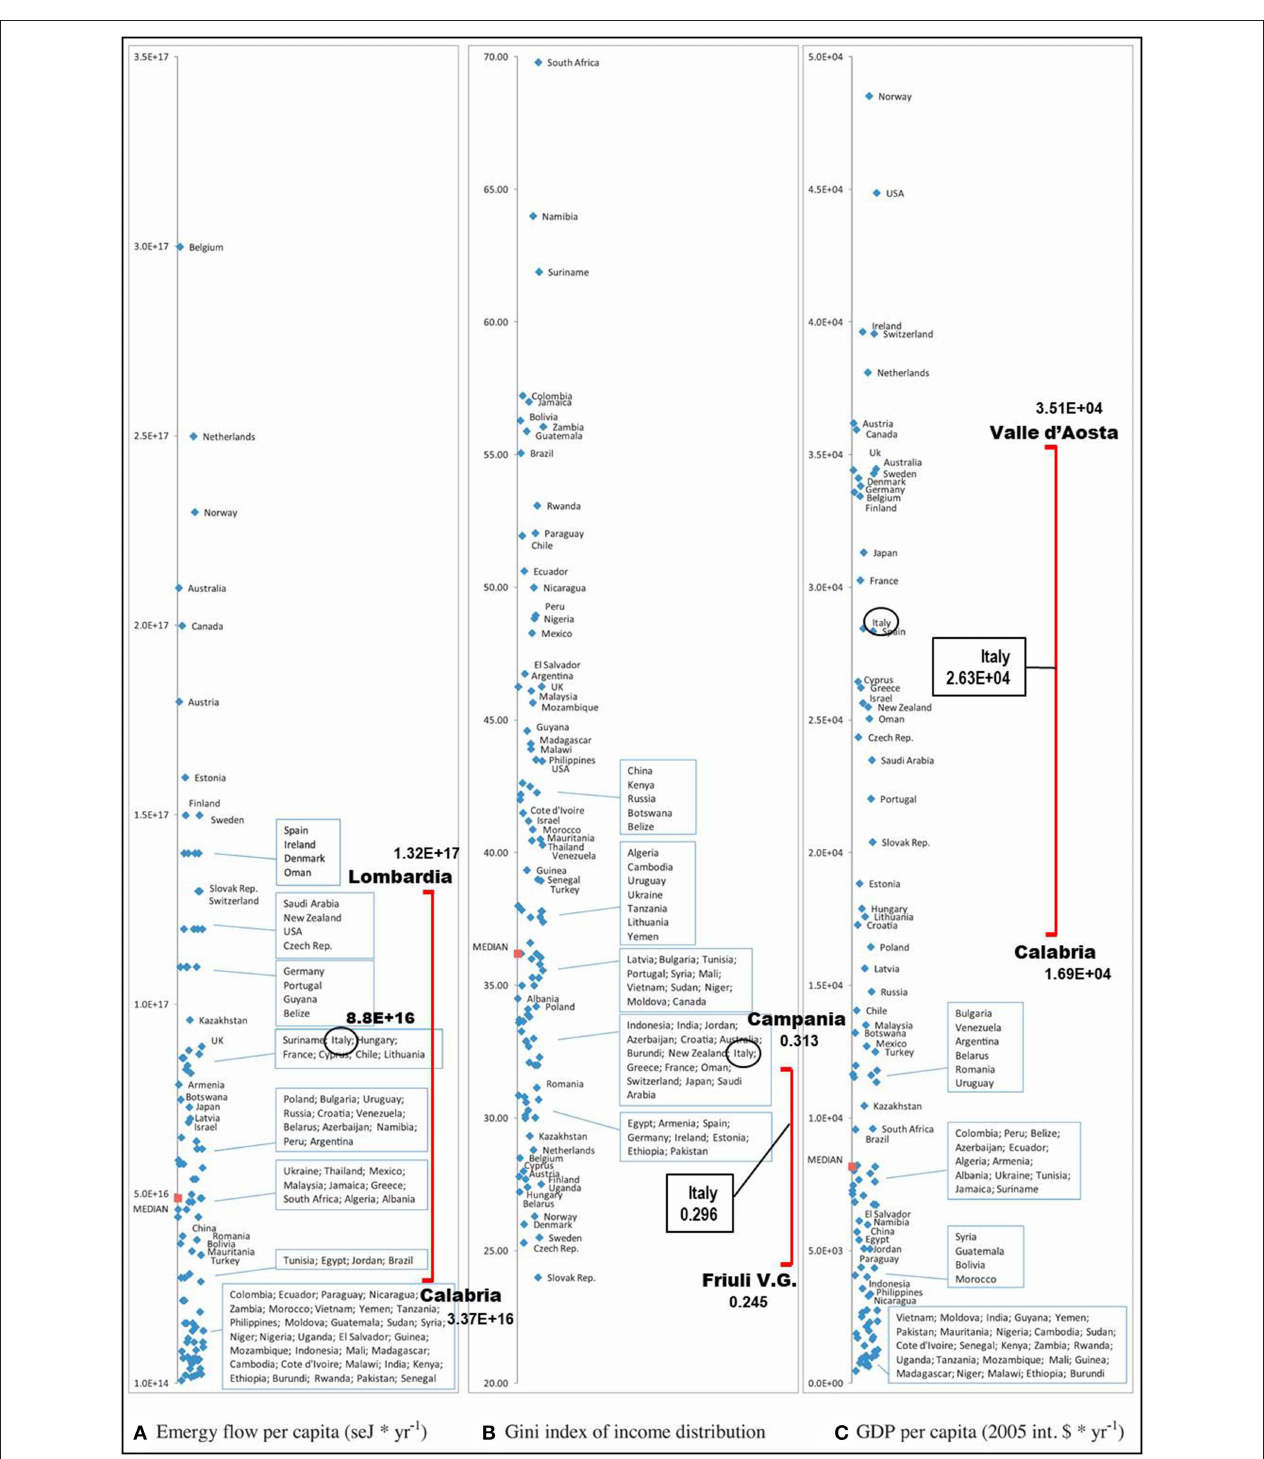
FIGURE 6 | Range (min. and max. values of the three indicators) of Italian regions within the global distribution of world countries. Modified after Pulselli et al. (2015).